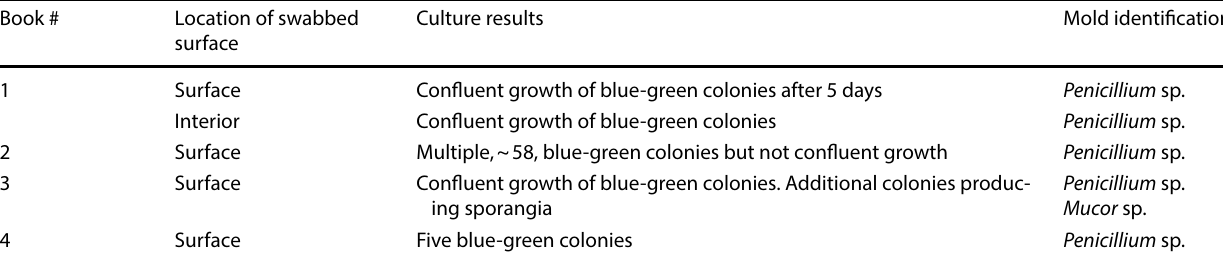
Table 3 Summary of culture results and microscopic identification of molds from contaminated books Book